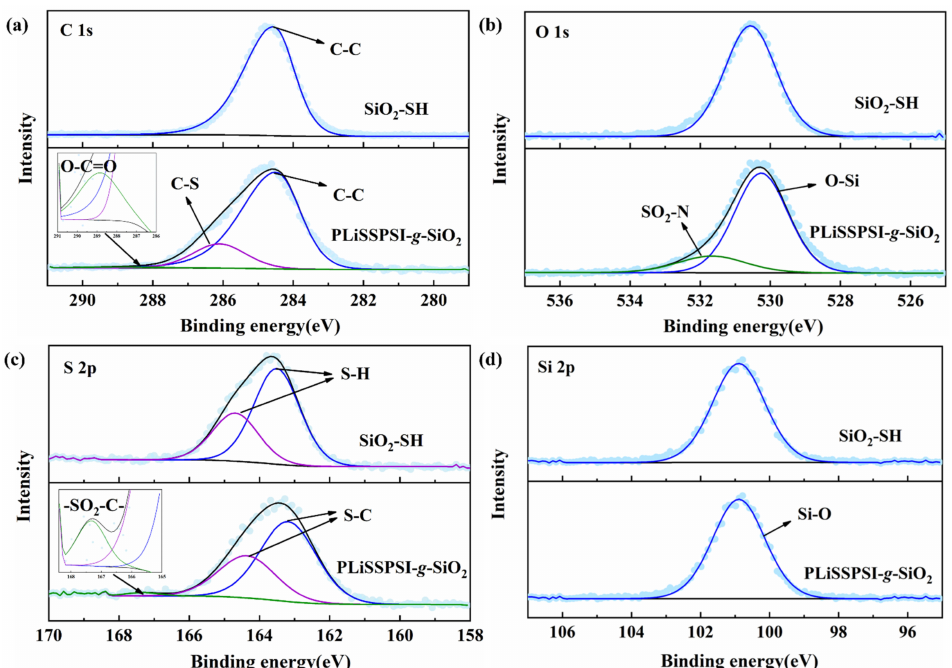
Figure 3. High-resolution XPS spectra of ( a ) C 1s, ( b ) O 1s, ( c ) S 2p and ( d ) Si 2p for SiO 2 -SH and PLiSSPSI- g -SiO 2 .